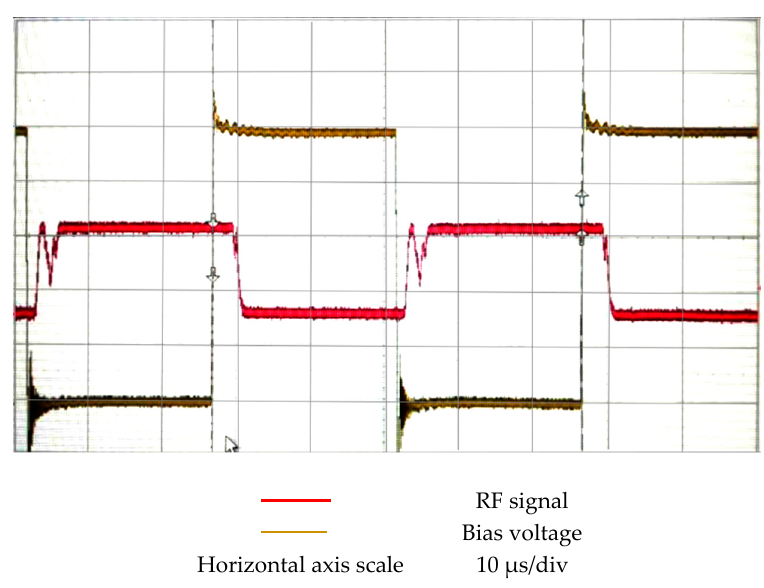
Figure 11. The measurement results of the actuation time and releasing time.